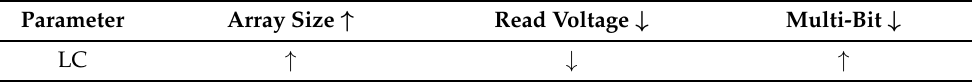
Table 3. Summary of the influence of the design parameters on the leakage